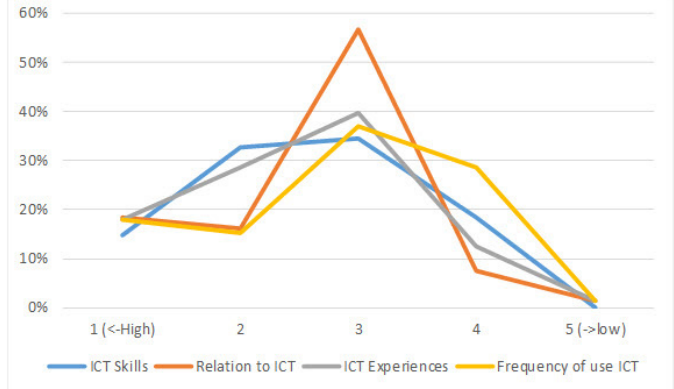
Figure 3. Respondents’ responses to their ICT skills, the experience of using ICT in teaching, frequencies of use of ICT in work and their relationship to ICT (scale